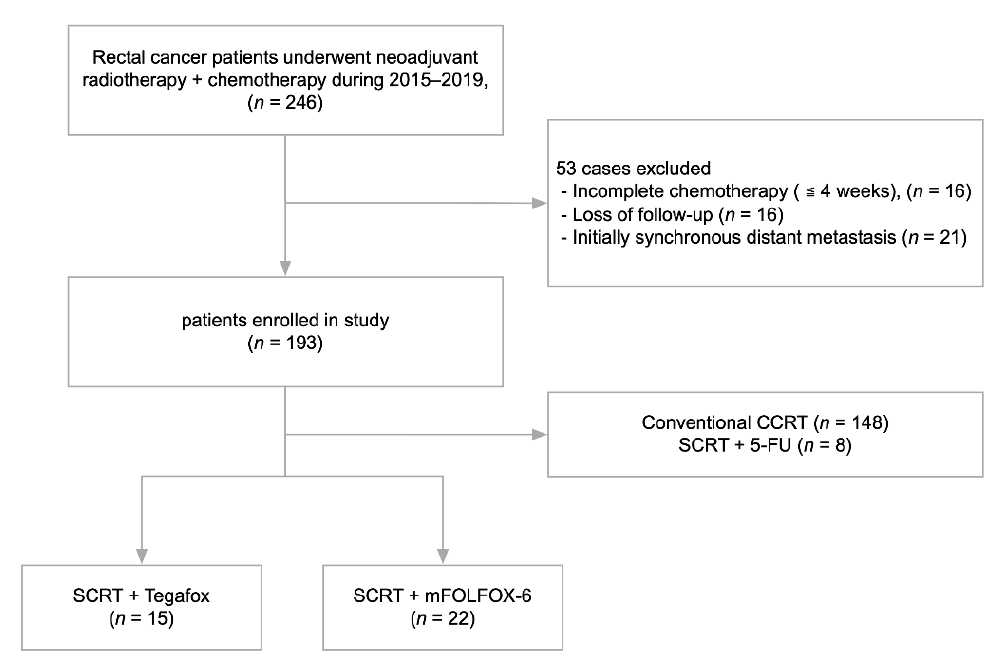
Figure 1. Patient selection flowchart. CCRT: concurrent chemoradiotherapy; SCRT: short-course ra- diotherapy.